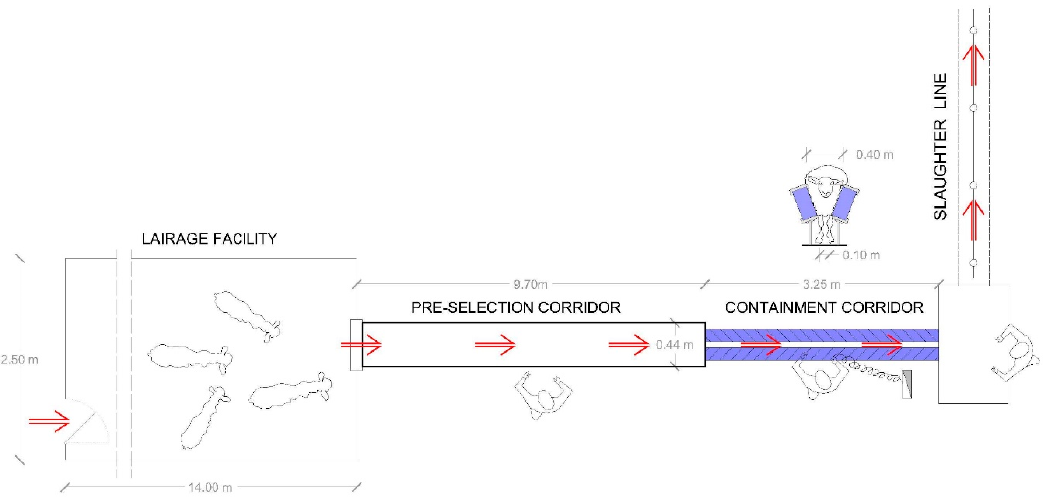
Figure 1. Plan of the slaughterhouse for the lambs slaughtering. Pre-selection corridor: leads to the site of jugulation (for ritual slaughter) or to the site where the stun electric gripper is present (for traditional slaughter). Containment corridor: can accommodate a maximum of three lambs at the time, and it is composed of a movable belt that allows both to immobilize the animal, blocking its limbs, and to move it forward through a pedal knob operated by the slaughterhouse staff.